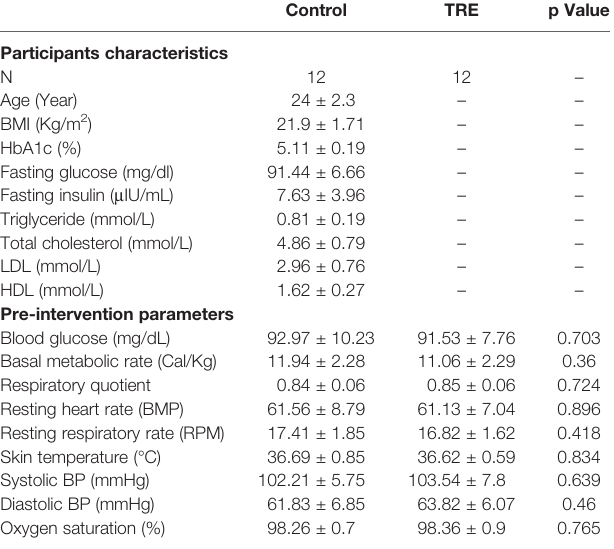
TABLE 1 | Basal characteristics of participants and pre-intervention parameters.